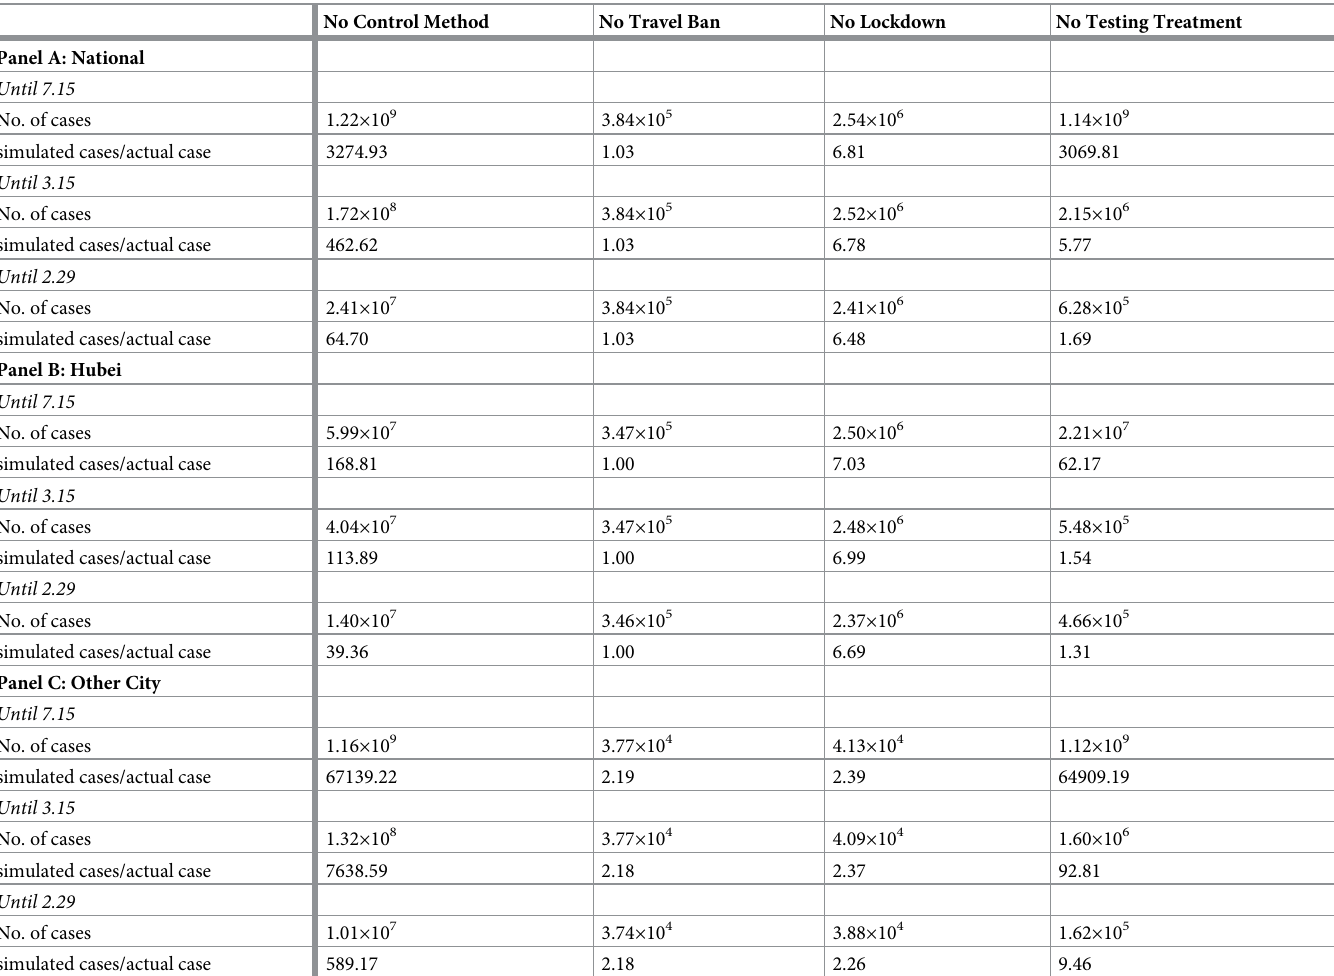
Table 2. Alternative scenario lifting each control